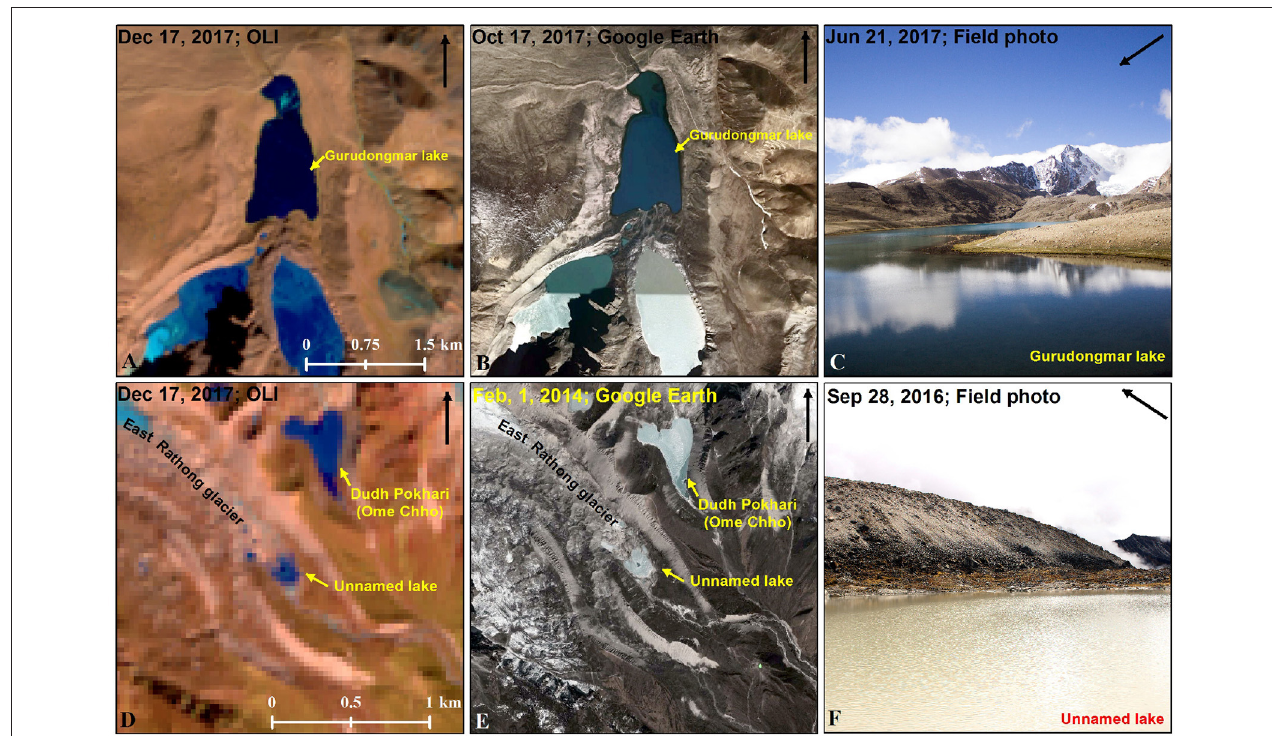
FIGURE 2 | Map showing the satellite image and field photograph of two lakes in the study area. Panels (A–C) display the appearance of Gurudongmar lake on OLI, Google Earth and field, respectively. Panels (D–F) shows the appearance of an unnamed lake developed near the snout of East Rathong glacier on OLI, Google Earth and field, respectively. Black arrows shown in all the panels show the north direction. For location of lakes please refer Figure 1 .